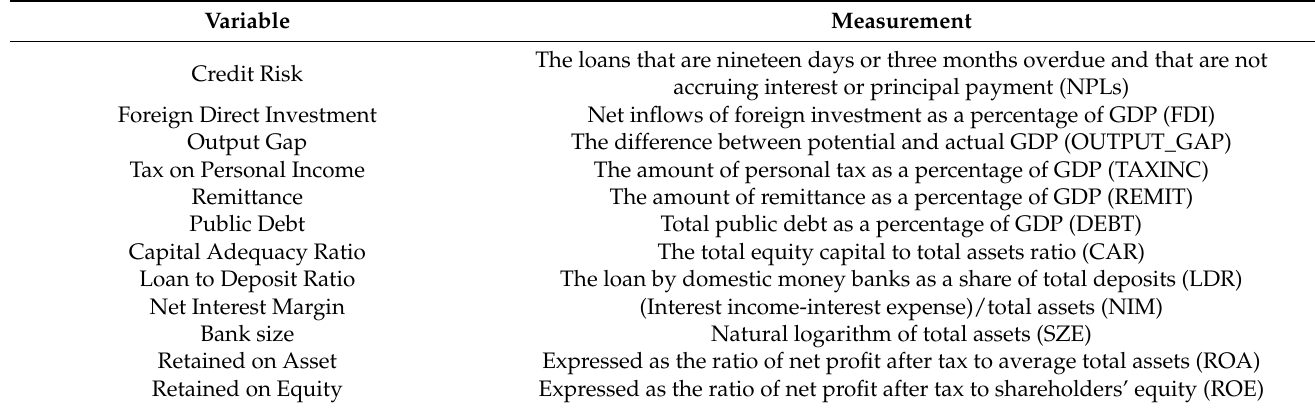
Table 1. Variables